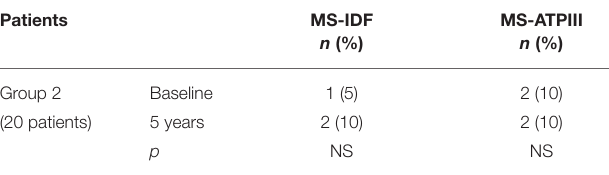
TABLE 7 | The prevalence of MS in controls (group 2) at study entry and after 5-year follow-up.